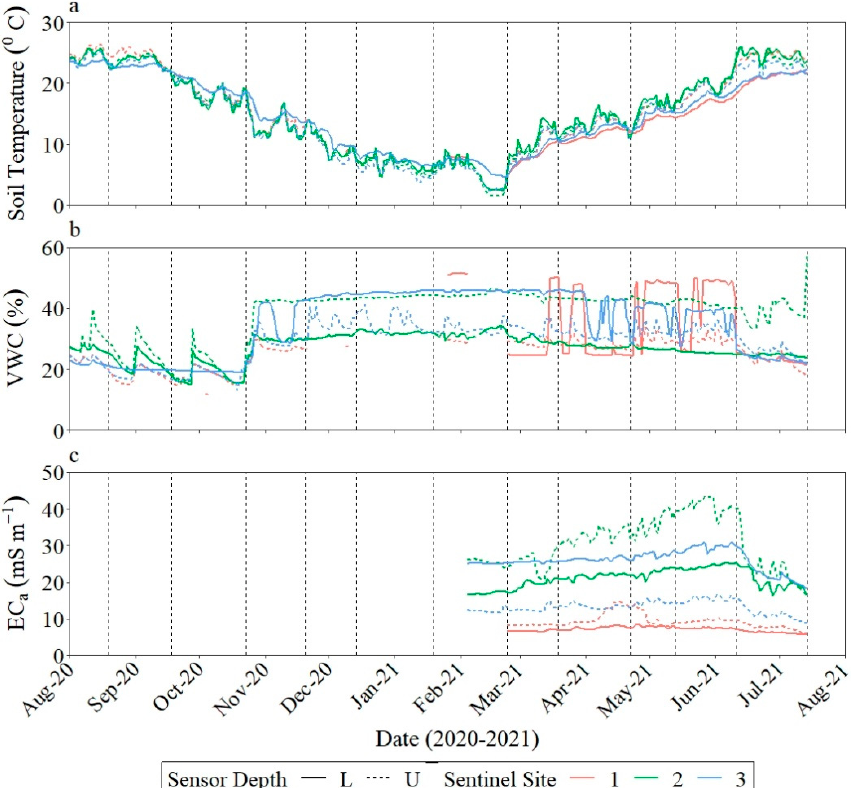
Figure 3. The recorded daily mean soil temperature (temp; ( a )), volumetric water content (VWC; ( b )), and apparent electrical conductivity (EC a ; ( c )) for the upper (U; 15, 15, 15 cm, respectively) and lower (L; 75, 75, and 50 cm, respectively) soil sensor depths at Sentinel Site 1, 2, and 3, at the agroforestry site in Fayetteville, AR. Electromagnetic-induction EC a surveys dates are represented by the vertical dashed lines. Figures were created in R Studio (version 4.05, R Core Team, Boston, MA, USA).